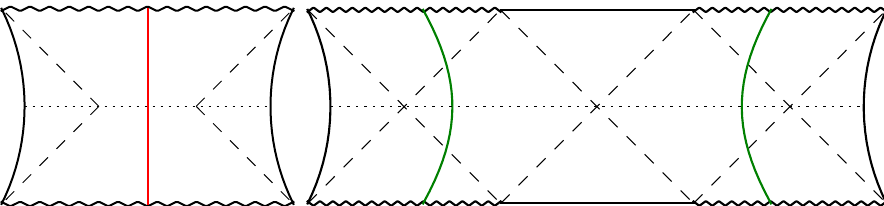
Figure 2 . Penrose diagrams obtained from the Wick rotation of the Euclidean solutions in (cid:12)gure 1 and analytic continuation to the past. Left: a two sided AdS 2 black hole with an elongated throat due to the presence of the massive brane. Right: an in(cid:13)ating bubble that is nucleated inside the AdS 2 throat. The domain walls (green) fall though the black hole horizons. In the 4 d embedding, the in(cid:13)ating region has the spatial topology of R (cid:2) S 2 . At (cid:12)rst, the R factor expands exponentially and the 2-sphere slowly. Eventually, the expansion becomes isotropic and we obtain a locally dS 4 solution. As seen, the classically extended geometry is singular in the past as dictated by the Penrose singularity theorem [1,